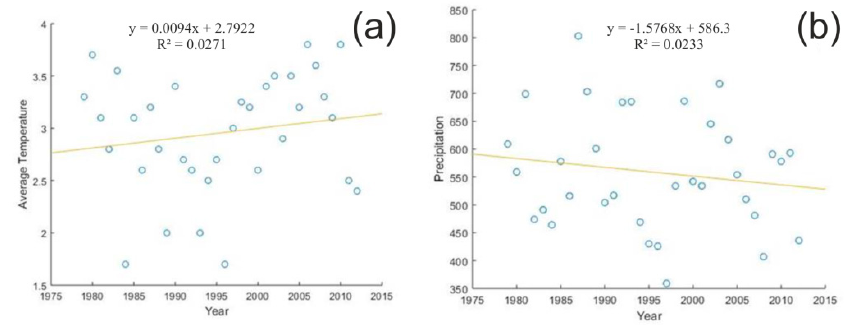
Figure 3. ( a ) Average annual air temperature (°C) and ( b ) annual precipitation totals (mm) from Alplager meteorological station in the period of 1979–2013.